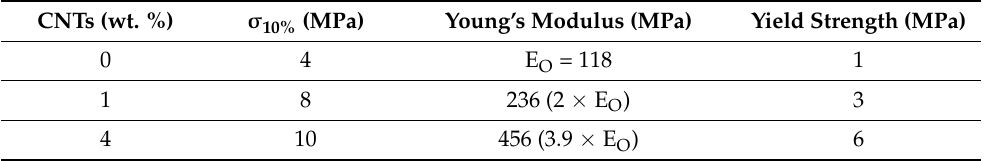
Table 12. Yield strength and Young’s modulus at different strain levels and CNT loading. CNTs (wt. %) σ 10%